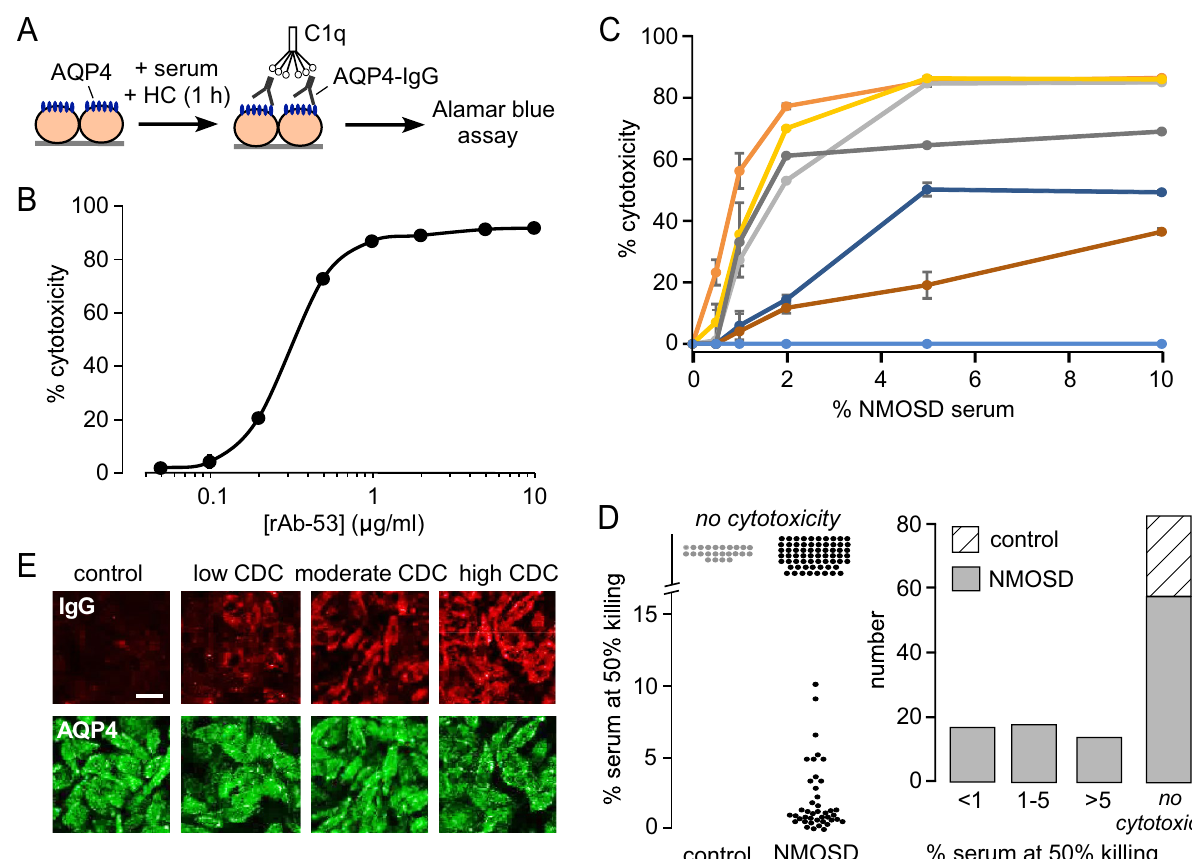
Figure 1. Heterogeneity in complement-dependent cytotoxicity (CDC) produced by sera from AQP4-IgG seropositive NMOSD patients. ( A ) CDC assay, in which AQP4-expressing cells were incubated with human complement (HC) and AQP4-IgG (monoclonal antibody or heat-inactivated patient sera), with Alamar blue readout of cytotoxicity. ( B ) CDC in AQP4-expressing CHO cells produced by different concentrations of monoclonal AQP4-IgG rAb-53 (mean ± S.D., n = 4). ( C ) CDC produced by different percentages of NMOSD patient sera (mean ± S.D., n = 4). Curves for 7 different NMOSD patient sera shown. ( D ) (left) Scatter plot of CDC, expressed as the percentage of serum giving 50% killing, for 108 AQP4-IgG seropositive NMOSD sera and 25 (non-NMOSD) control sera. (Right) Histogram of CDC deduced from data on the left. ( E ) AQP4-IgG seropositivity study in which AQP4-IgG-expressing CHO cells were incubated with test sera, washed, and then immunostained for human IgG (red) and AQP4 (green). Micrographs shown for one control serum and three NMOSD sera which (in experiments as in C ) produced different levels (low, moderate, high) of